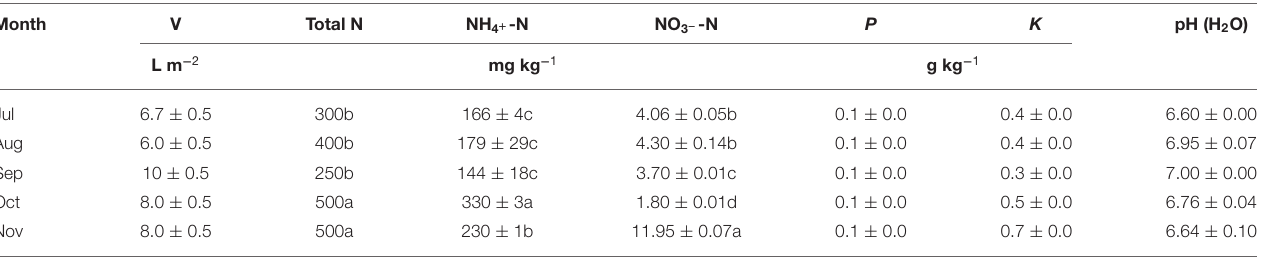
TABLE 1 | Volume (V) and chemical characteristics on a fresh weight basis of the DFE applied in the field trial carried out in the Alfredo Volio Mata Experimental Station, Costa Rica, from July to November 2017. Month V Total N NH 4 + -N NO 3 −